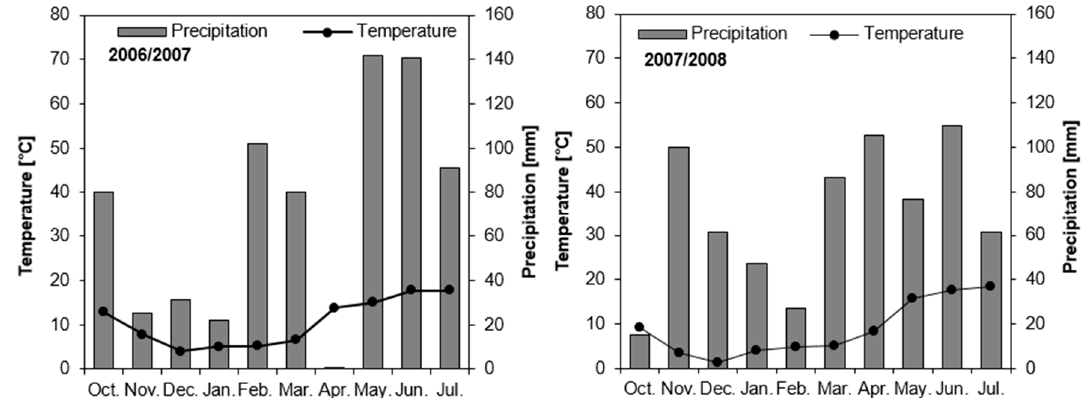
Figure 1. Air temperature ( ● ) and precipitation (bars) at the organic trial site Kleinhohenheim for the growing seasons 2006/2007 and 2007/2008.